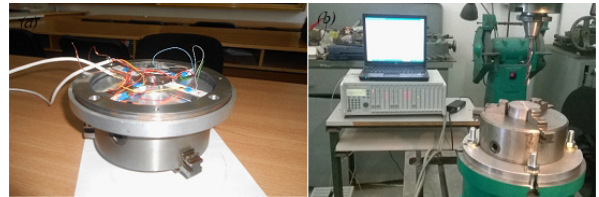
Figure 5. Assembly of the elastic element with the upper plate and the clamping